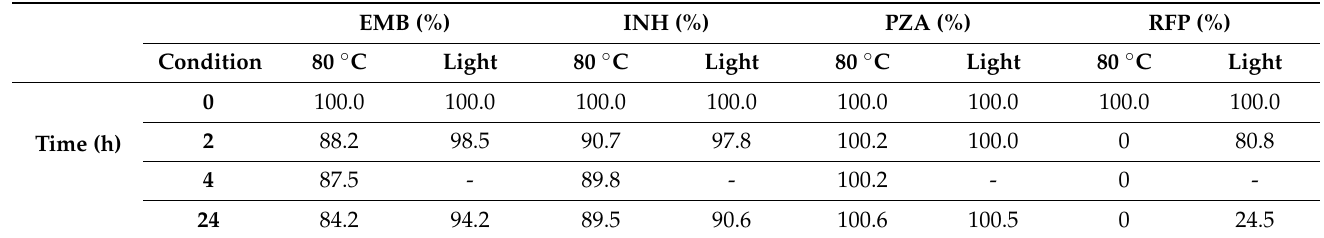
Table 4. Percentage of API remaining after being stored under stress conditions: temperature (80 ◦ C) and a source of light. EMB: ethambutol, INH: isoniazid, PZA: pyrazinamide, RFP: